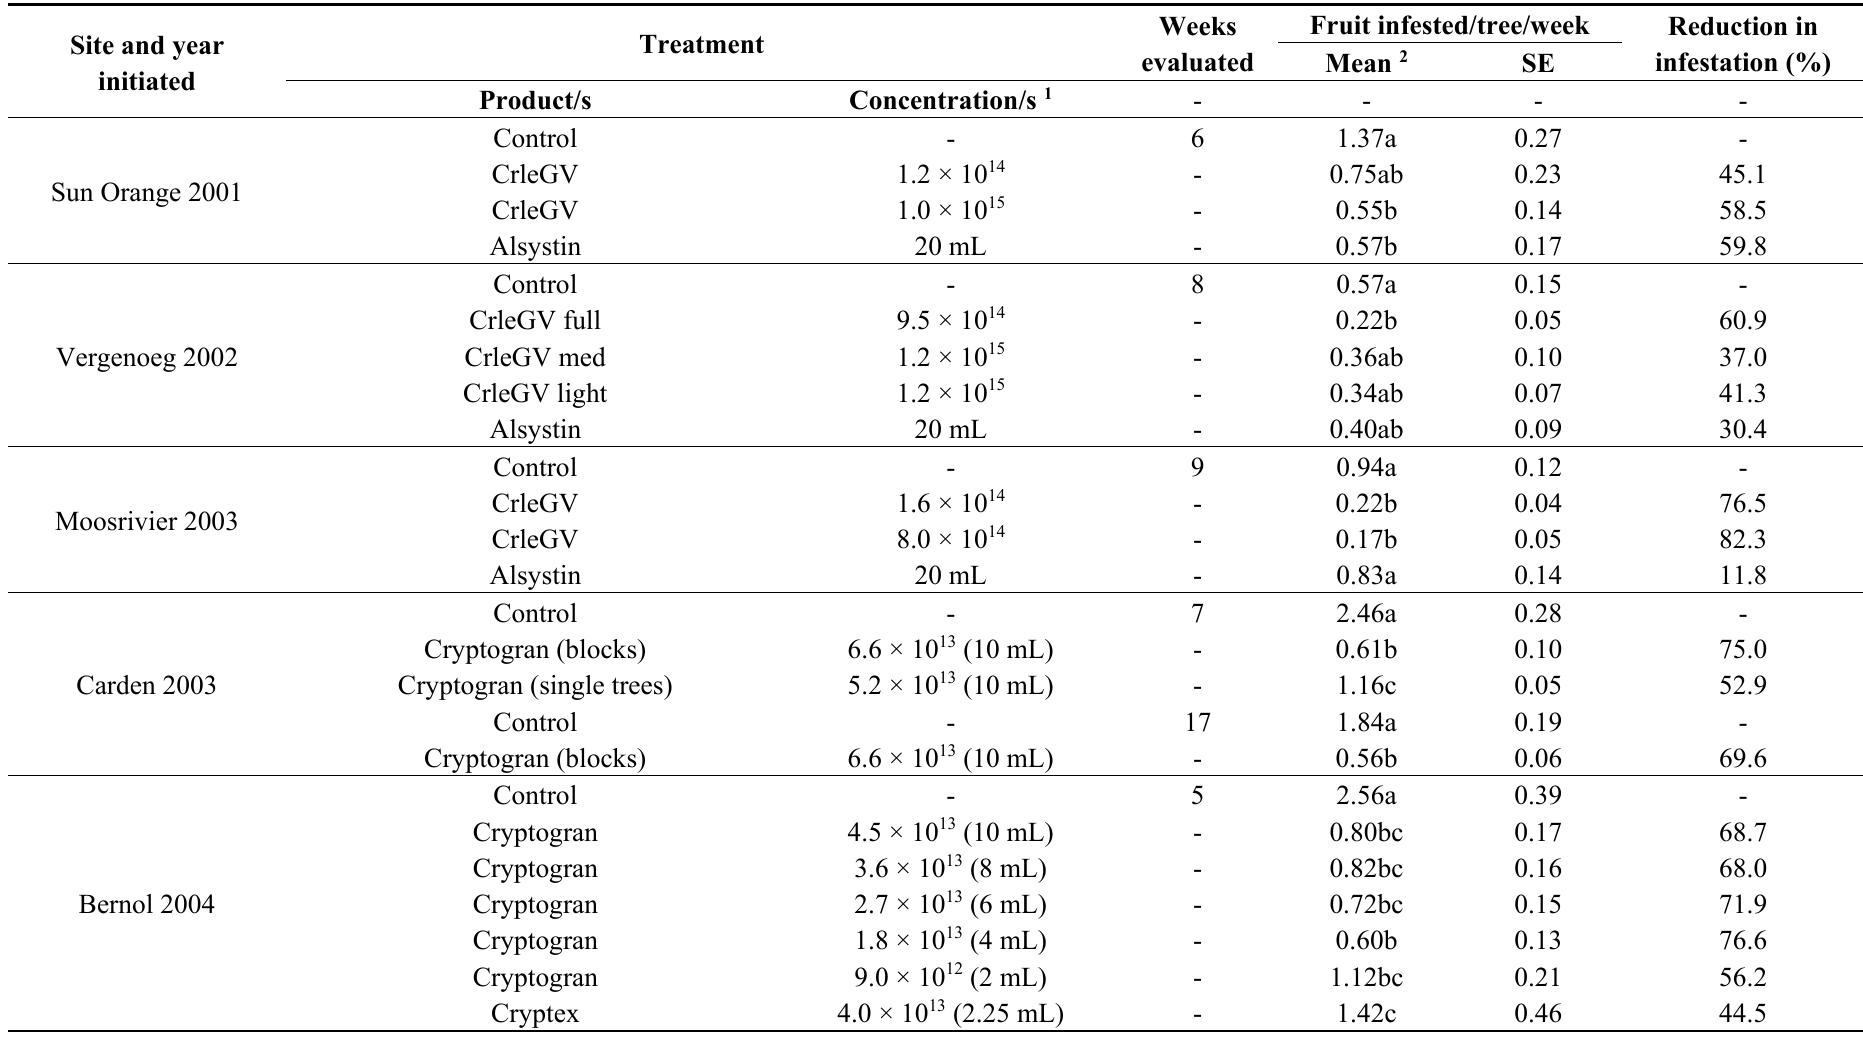
Table 1. Treatment efficacy of CrleGV and CrleGV-based biopesticides and chemical standards against T. leucotreta in citrus field trials. Efficacy was measured by the reduction in numbers of fruit infested with T. leucotreta larvae relative to untreated control